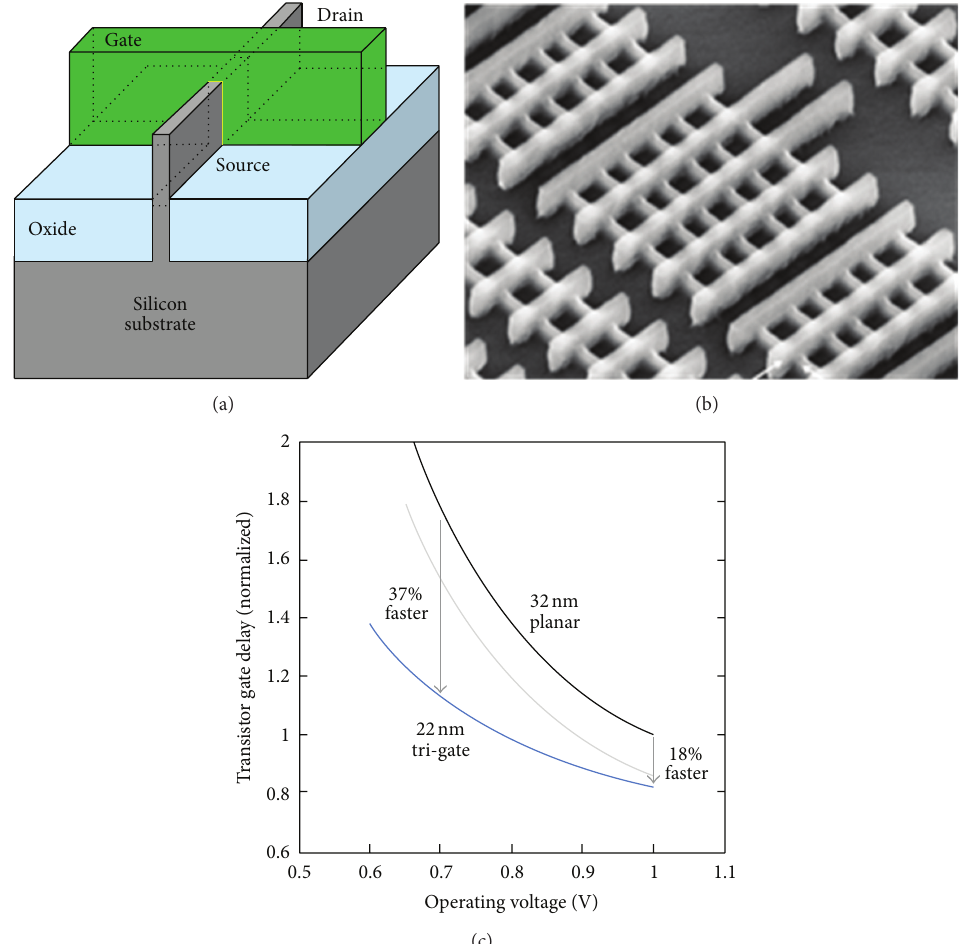
Figure 11: Fully depleted Tri-Gate Transistor developed by Intel